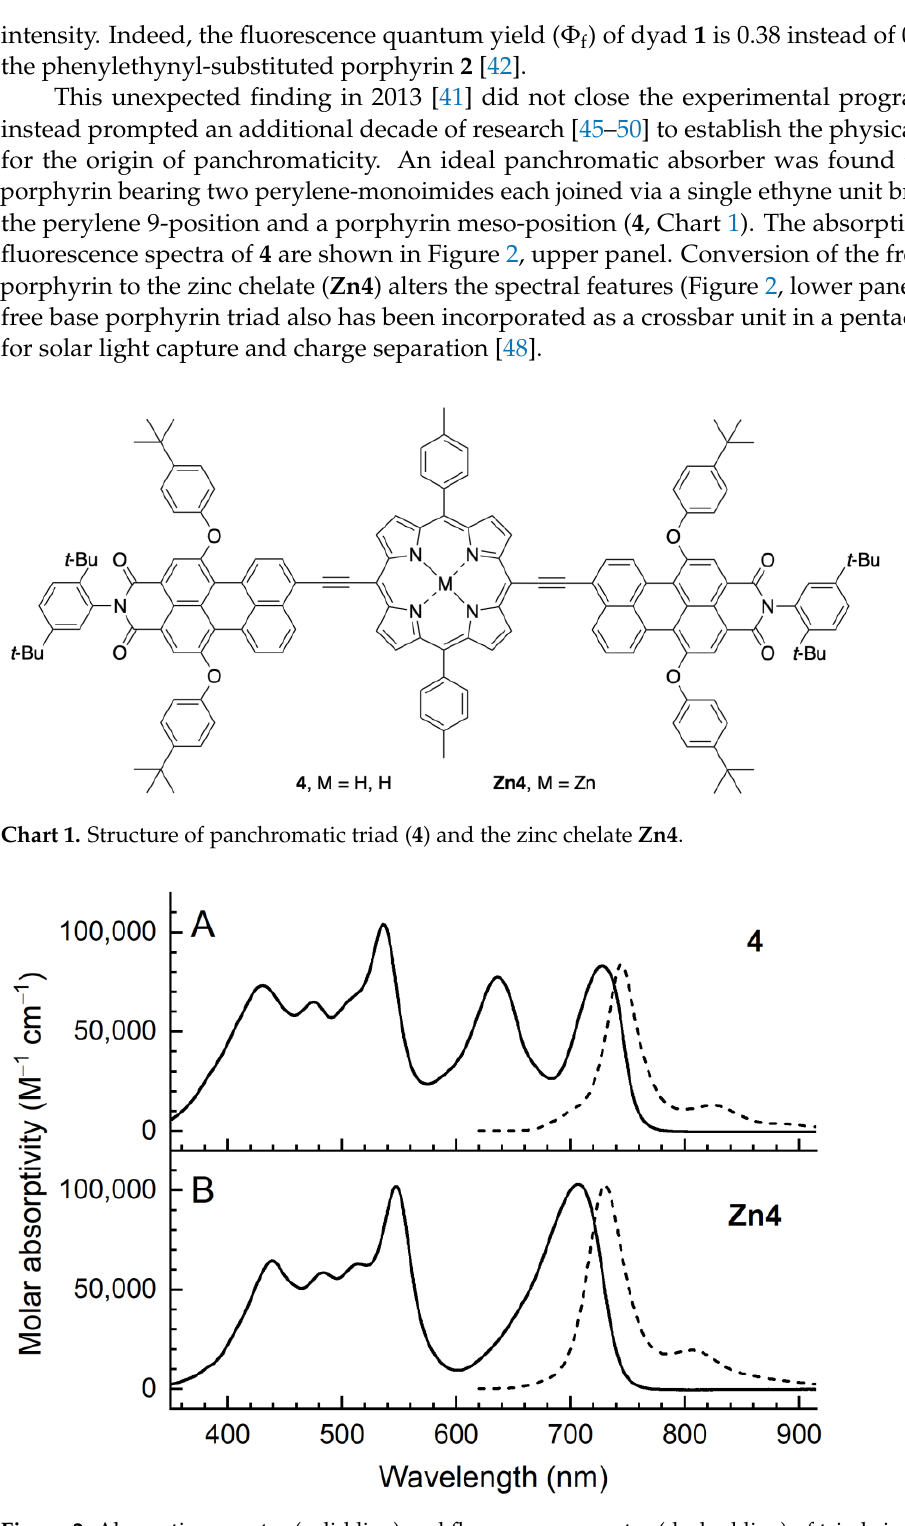
Figure 2. Absorption spectra (solid line) and fluorescence spectra (dashed line) of triads in toluene at room temperature. The molar absorption coefficient values for free base porphyrin triad 4 are as follows: 431 nm (73,200 M − 1 cm − 1 ), 537 nm (104,000 M − 1 cm − 1 ), 637 nm (77,400 M − 1 cm − 1 ), and 728 nm (83,200 M − 1 cm − 1 ) [42,45]. The molar absorption coefficient values for zinc porphyrin triad Zn4 are as follows: 439 nm (64,700 M − 1 cm − 1 ), 548 nm (102,000 M − 1 cm − 1 ), and 707 nm (103,000 M − 1 cm − 1 ) [45]. The Φ f value of 4 is 0.26, whereas that of Zn4 is 0.30